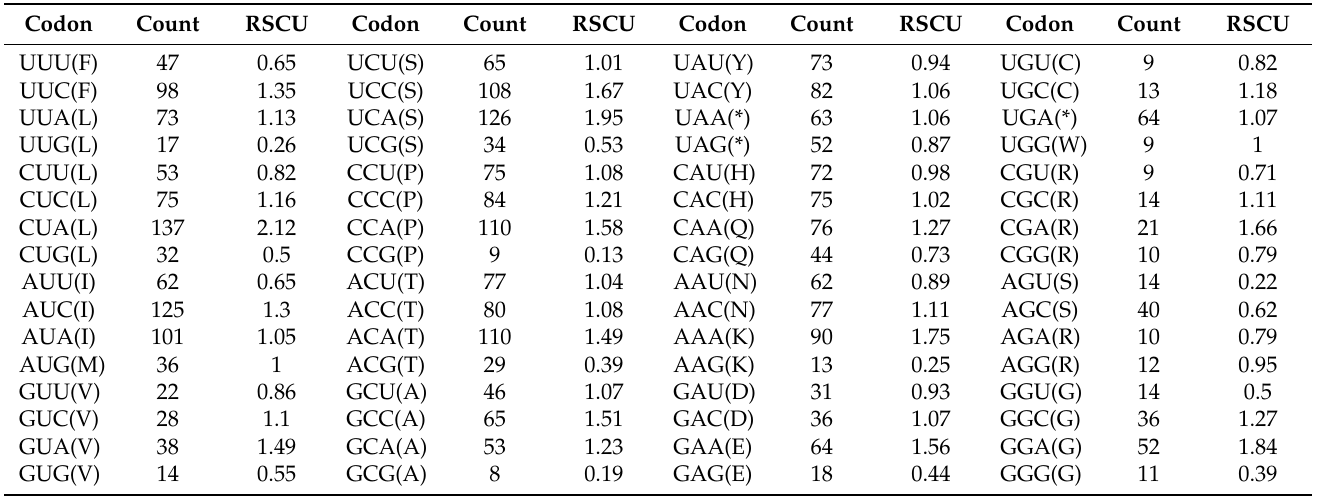
Table 3. Codon number and relative synonymous codon usage (RSCU) of Huaibei grey donkey mitochondrial DNA.